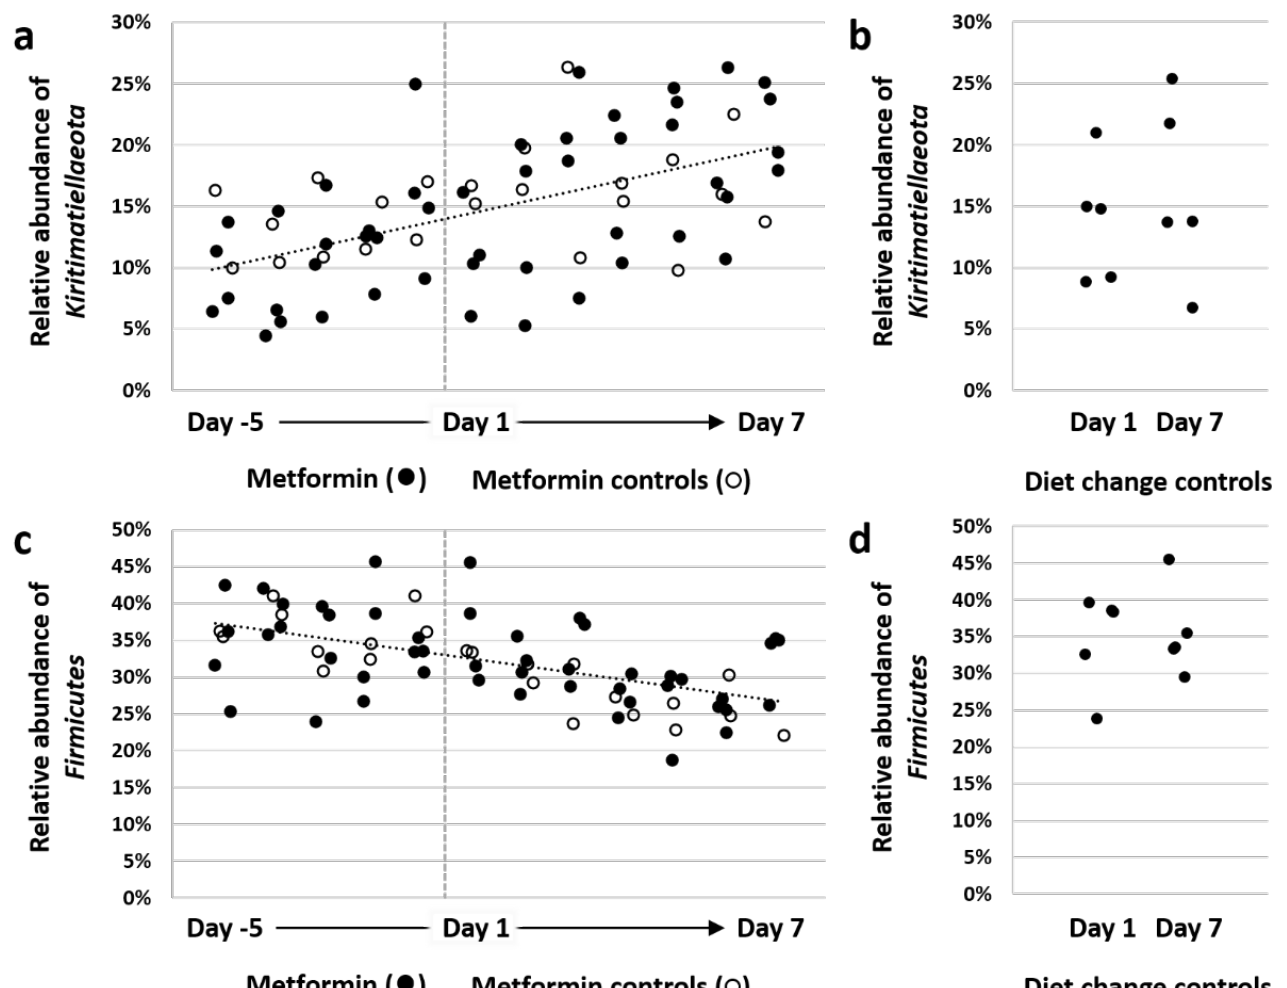
Figure 4. Change in Kiritimatiellaeota and Firmicutes over time following diet change. Dot plot showing the relative abundance of Kiritimatiellaeota in feces of horses switched to an all-hay diet on Day − 5, and administered metformin (closed circles) from Day 1 through Day 7 ( n = 6, a ); and feces of horses maintained on pasture and not receiving metformin at Day 1 and Day 7 ( n = 5, b ); and dot plots showing the relative abundance of Firmicutes in those same experimental ( c ) and control ( d ) horses. Vertical grey line in panels ( a ) and ( c ) denotes the initiation of metformin administration in Horses 1 to 4.